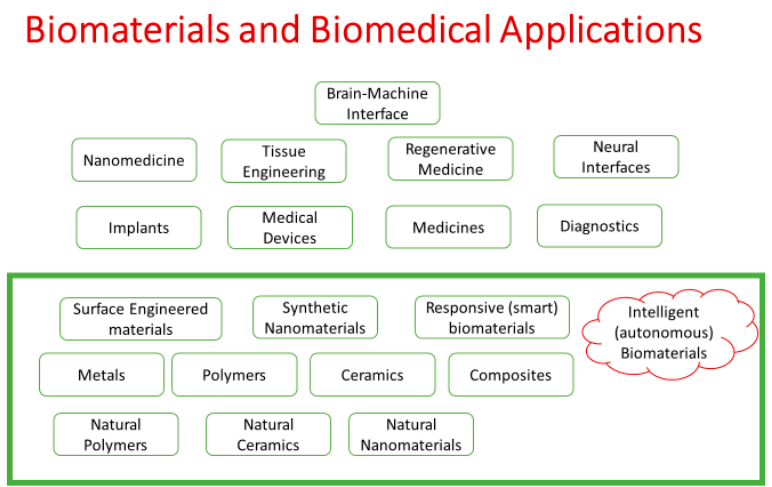
Figure 3. Classification of intelligent (autonomous) biomaterial based on their structure and prop ‐ erties for biomedical